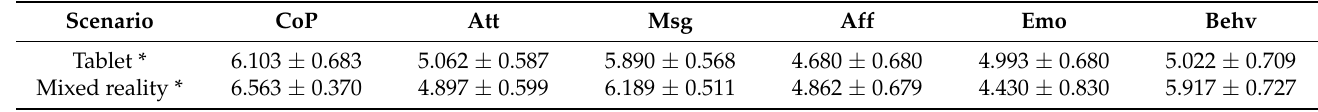
Table 1. Mean and standard deviation (SD) values for constructs and each test.